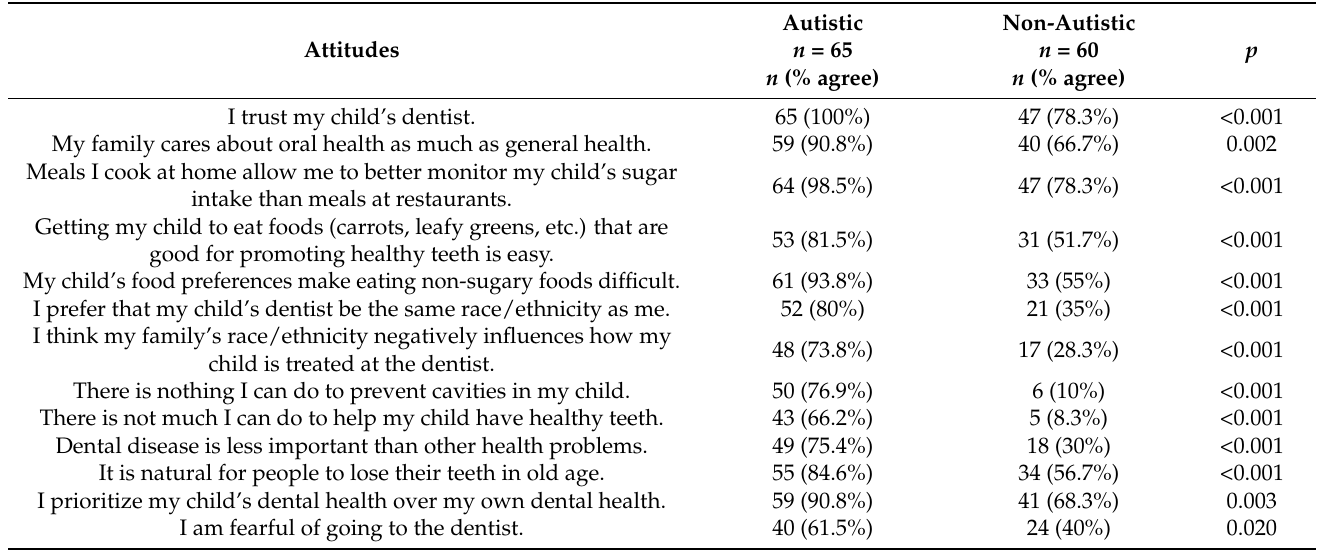
Table 3. Significant Differences in Individual Items of Oral Care Attitudes of Families with Autistic Children and Children Without